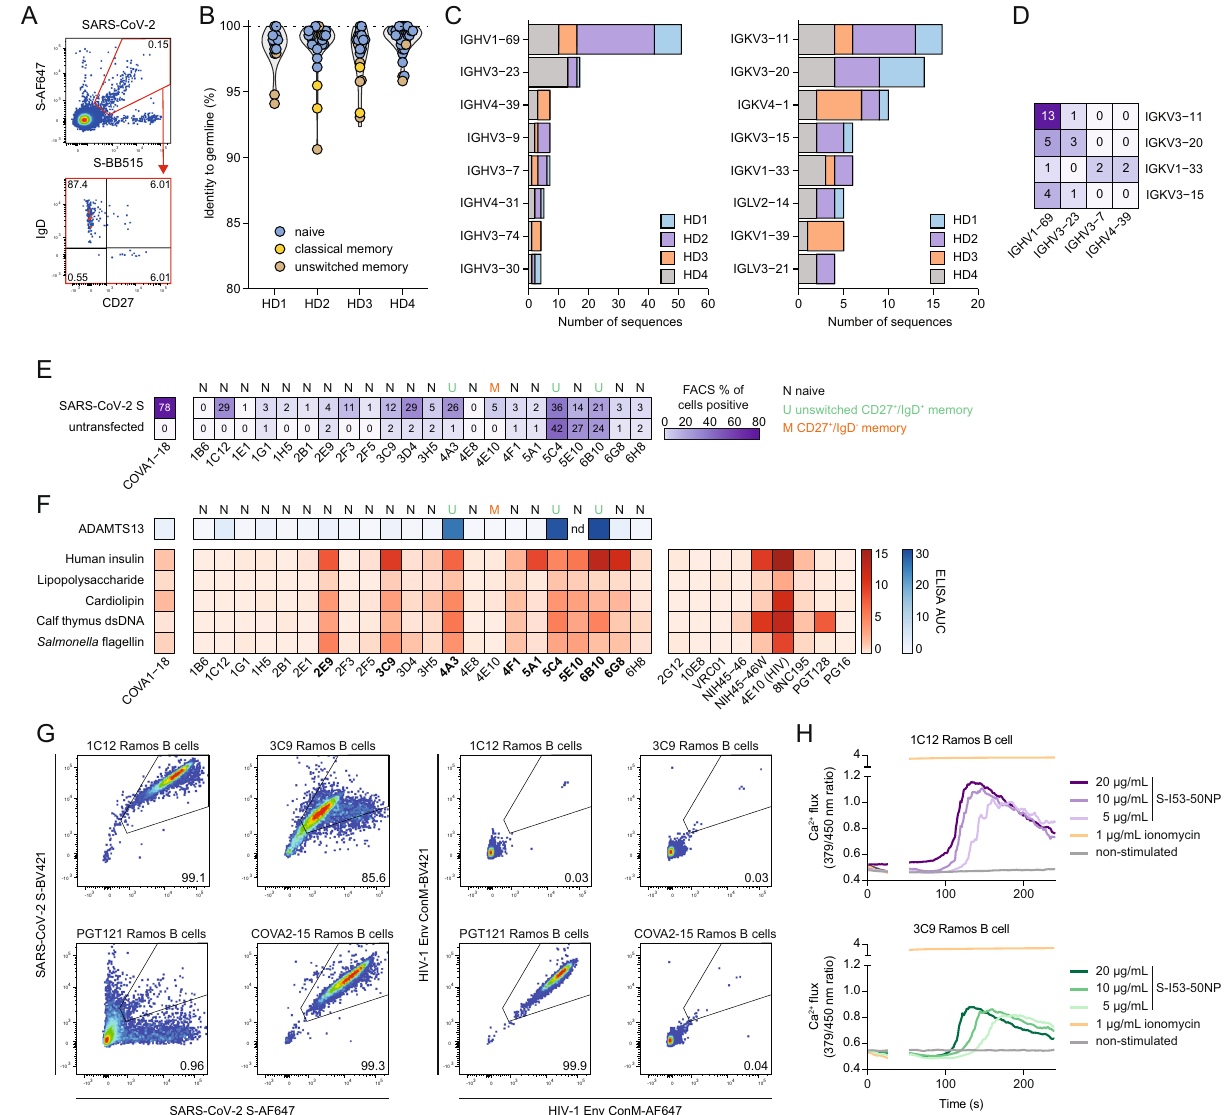
Fig. 2 | Genotypic and phenotypic characterization of SARS-CoV-2 S-reactive monoclonal antibodies from unexposed individuals. A Representative gating strategyofSARS-CoV-2S-reactiveBcells.Antigen-reactiveBcells,wereassociated to naïve, unswitched IgD + memory, CD27- memory, and classical memory phe- notype) (lower panel). B Dot plot overlaying a violin plot showing sequence identity (%) to IMGT-annotated germline heavy chain sequences for all isolated BCR heavy chains. Each color represents a B cell phenotype from four healthy donors. HD, healthy donor. C Bar plot showing the number of sequences recov- ered for each immunoglobulin heavy chain V (IGHV, left panel) gene and immu- noglobulin kappa/lambda light chain (IGKV/IGLV, right panel) gene. Colored bars representdifferentHDs. D MatrixshowingthenumberofpairswithacertainIGHV (x-axis) and IGKV ( y -axis). The numbers inside the boxes represent the number of pairs recovered for each pairing. E Matrix showing fl ow cytometric binding assay to SARS-CoV-2 S-transfected or untransfected HEK293T cells for each selected